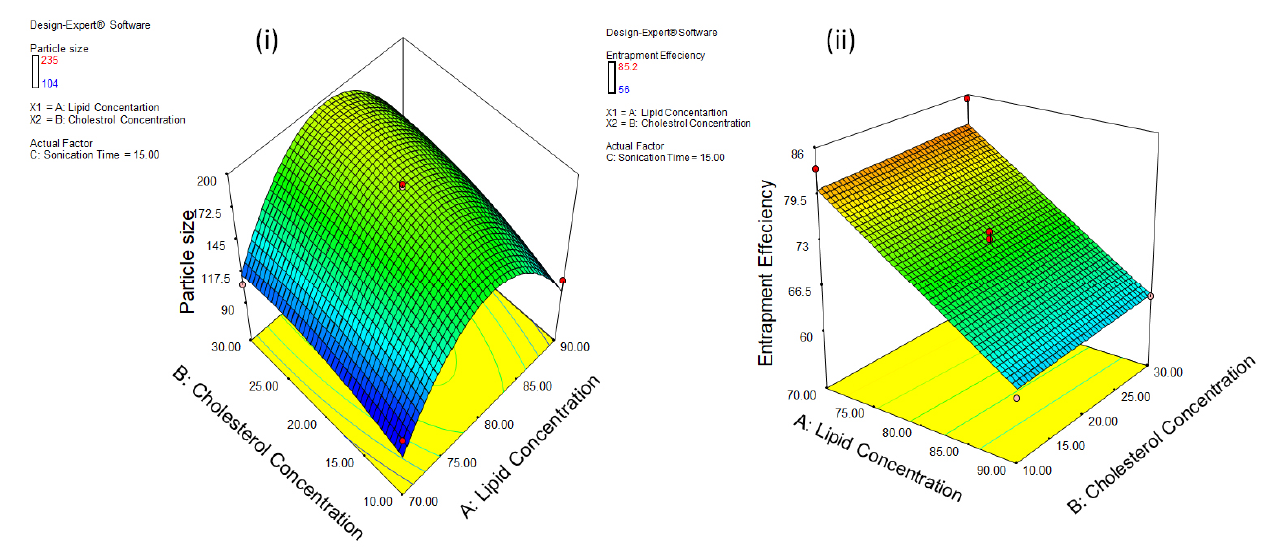
Figure 2. ( i ) Response surface plot and ( ii ) contour plot for particle size and entrapment efficiency.